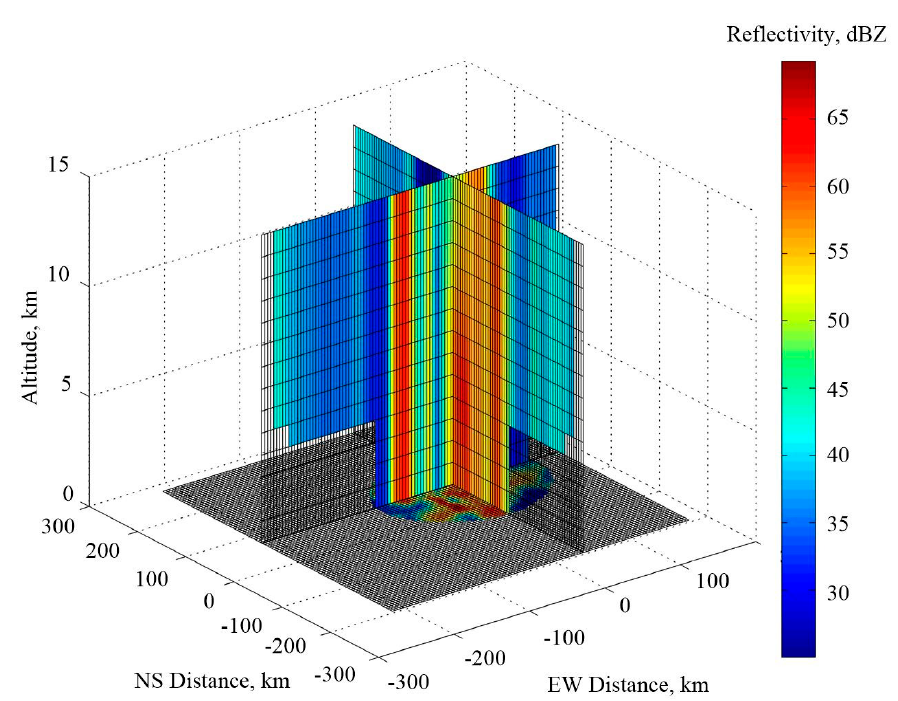
Figure 20. Description is the same as in Figure 16, except for the relevant positive lightning leader onset, indicated by Case #11 and slicing planes that are forward through the point indicated by the coordinates: x = 2.9 km, y = 20.7 km, z = 1 km. Again, the slicing cross-section altitude was increased here, from 0.2 km to its indicated value of 1 km.